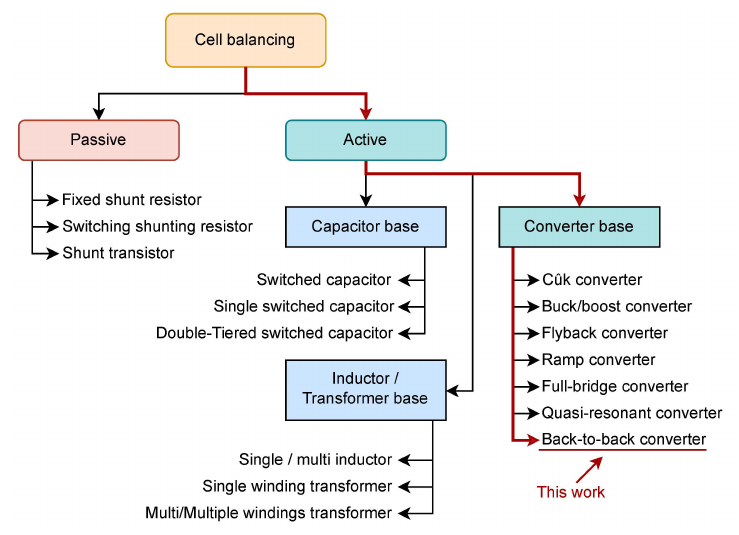
Figure 1. Classification of battery/cell equalization technologies [6].